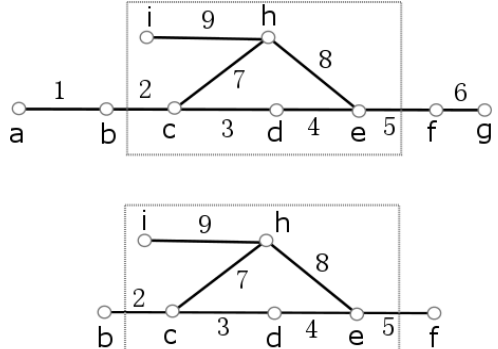
Figure 2. The illustrative road network (up) and a neighbouring area of it (bottom).